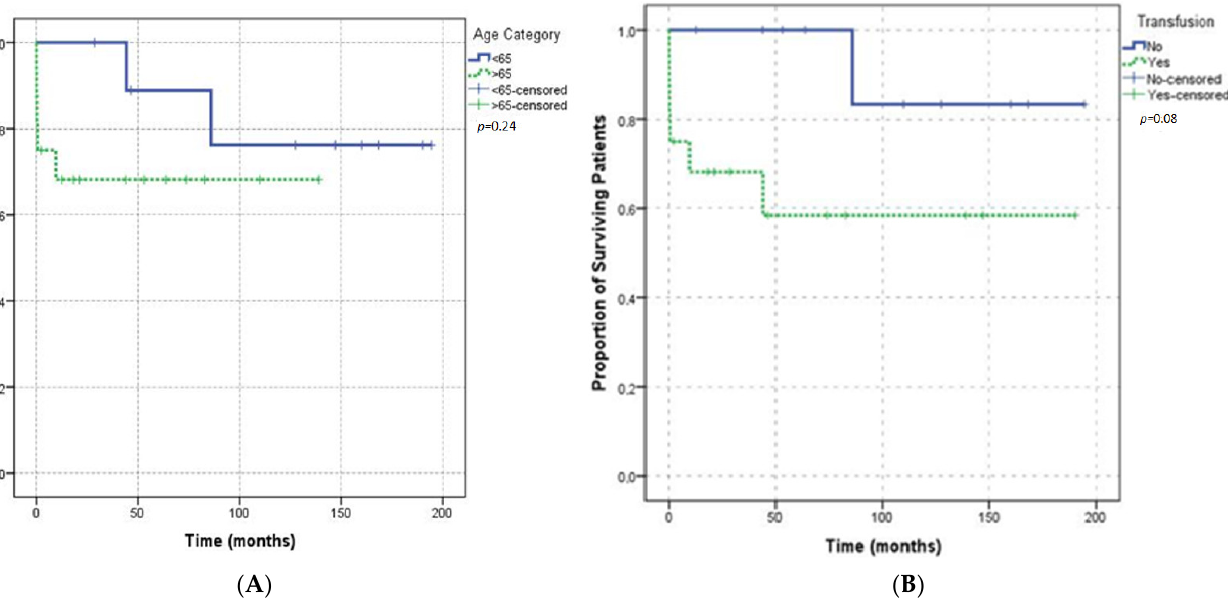
Figure 5. ( A ) Kaplan–Meier plot showing the overall survival according to age group. ( B ) Kaplan– Meier plot showing the overall survival according to transfusion requirements.